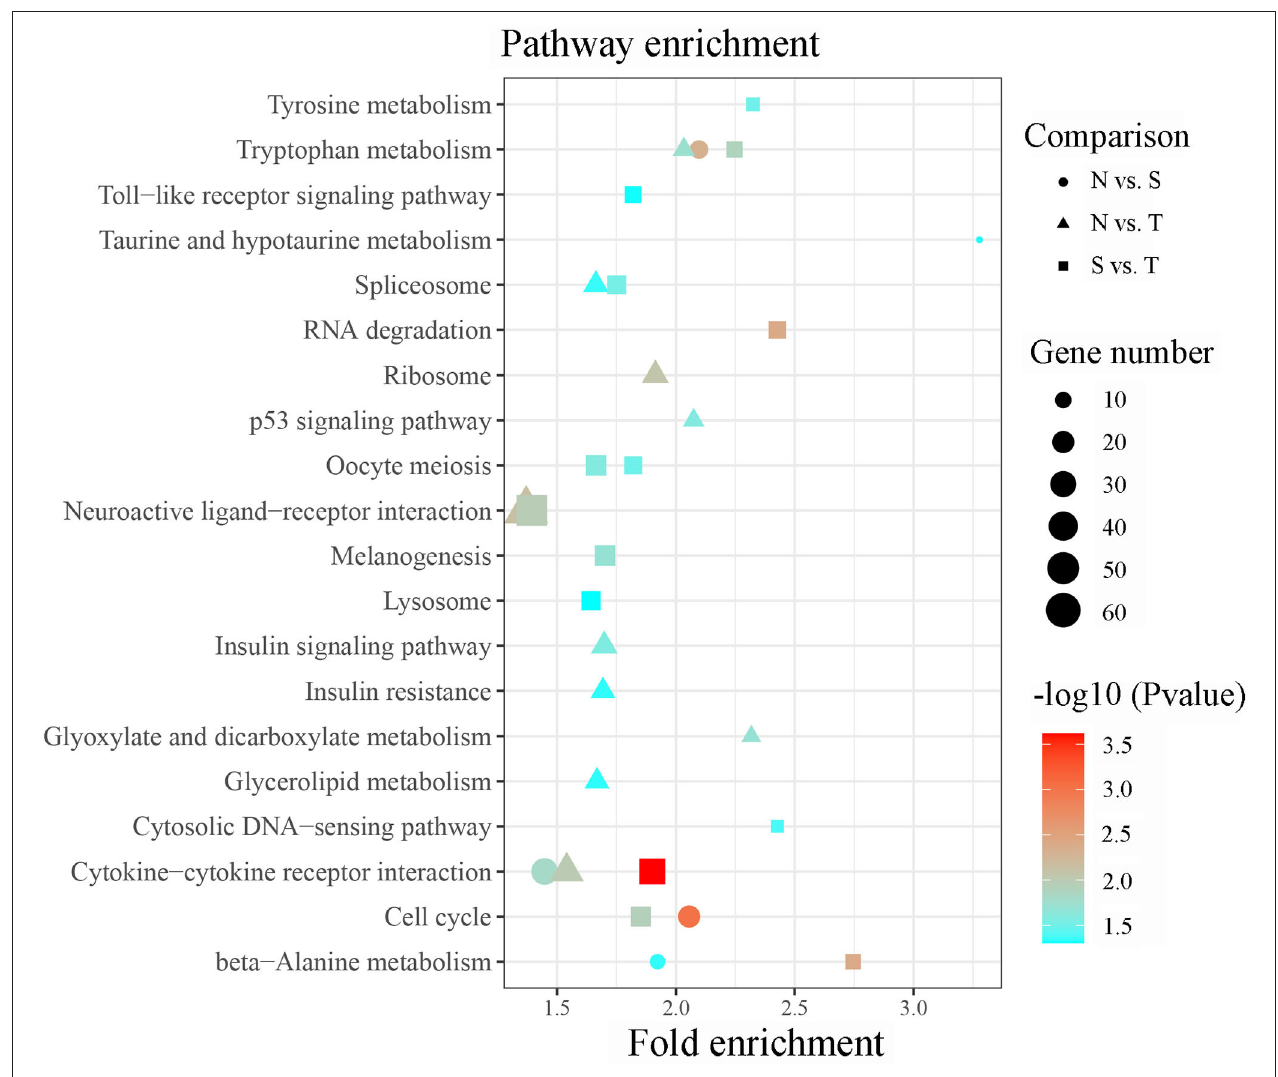
FIGURE 4 | Significant enriched KEGG pathway by cis/trans genes of the differentially expressed lncRNAs within susceptible vs. tolerant birds’ contrast.